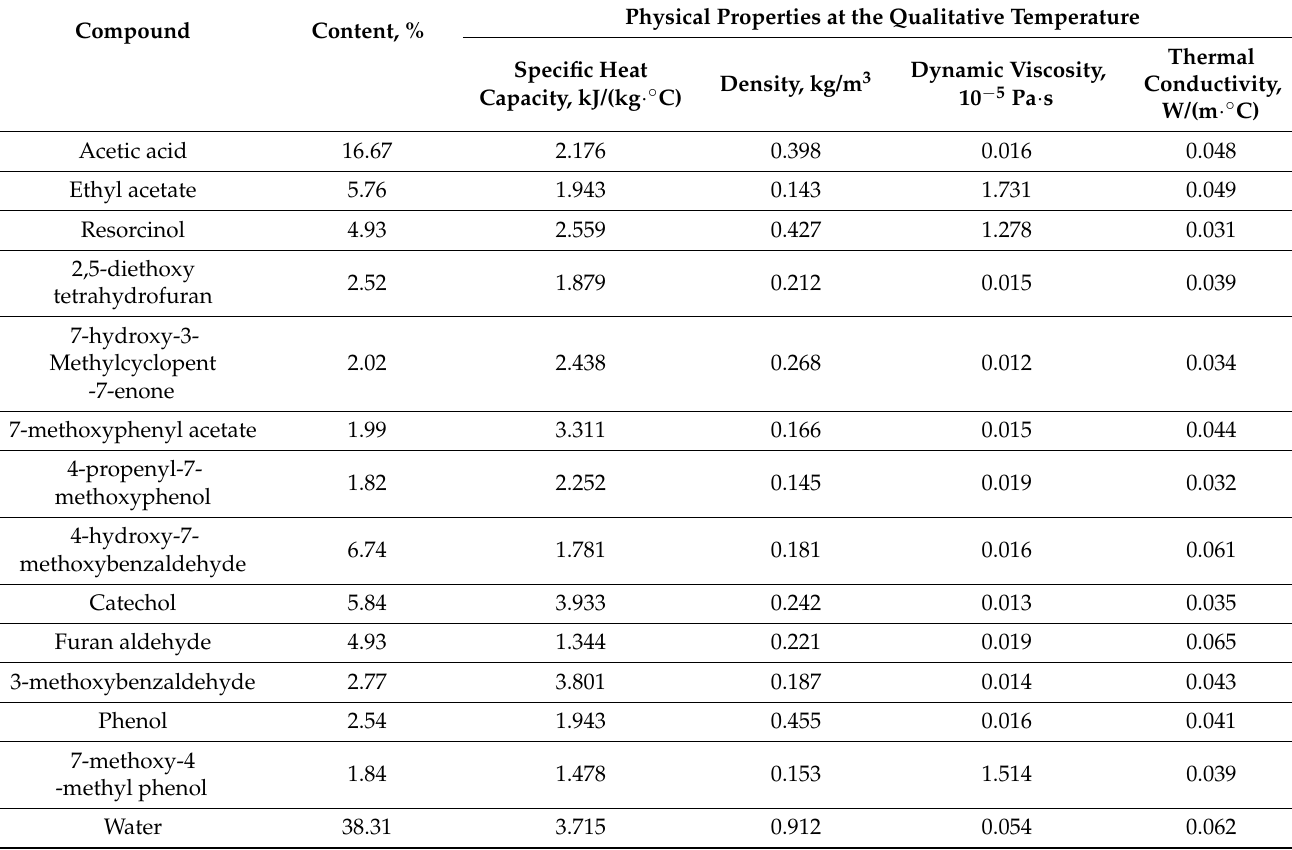
Table 3. Composition of Pyrolysis Steam Produced from Larch and The Physical Properties.